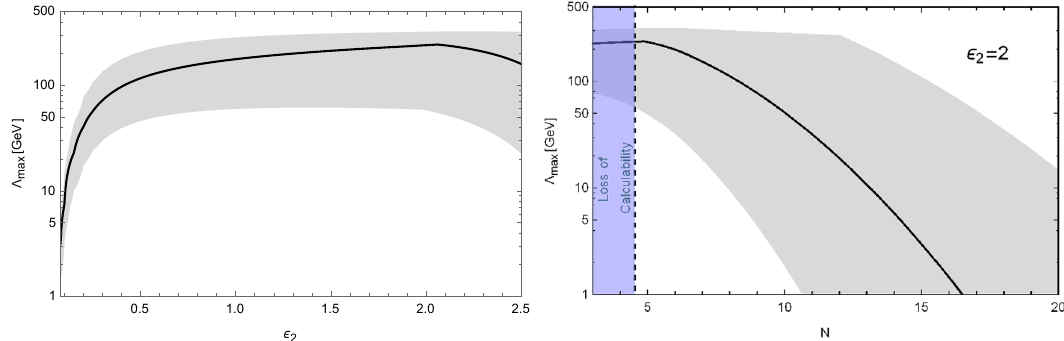
Figure 5 . An estimate for the highest value of the CC, Λ max , below which the CFT sector dynamically triggers the crunching of the corresponding region of space, shown with a black solid line as a function of (cid:15) 2 ( left ) and the number of colors in the CFT, N ( right ). Λ max satisfies the constraints discussed in section 5 and is calculated using our numerical methods laid out in appendix C. The gray region shows an uncertainty band which aims to take into account our ignorance when estimating the decay rate. In particular, we vary T ∗ in accordance to our two numerical estimates discussed in section 4.3 and illustrated in figure 4, and take Γ (4) to be in the 0 range 10 − 4 − 10 4 while S 4 = (0 . 5 − 2) · 3 N 2 / 16 . See appendix C.3 for more details. For the left plot we fix λ = 1 / 100 and take N to be the minimal value allowed by perturbativity and by our requirement that quantum gravity corrections do not start dominating before T ∗ [in accordance with eq. (C.4)]. For the right plot we fix (cid:15) 2 = 2 , and λ = 1 ( N/ 4 . 47) 14 / 3 . In that plot, the blue 60 vertical region lies beyond our calculable